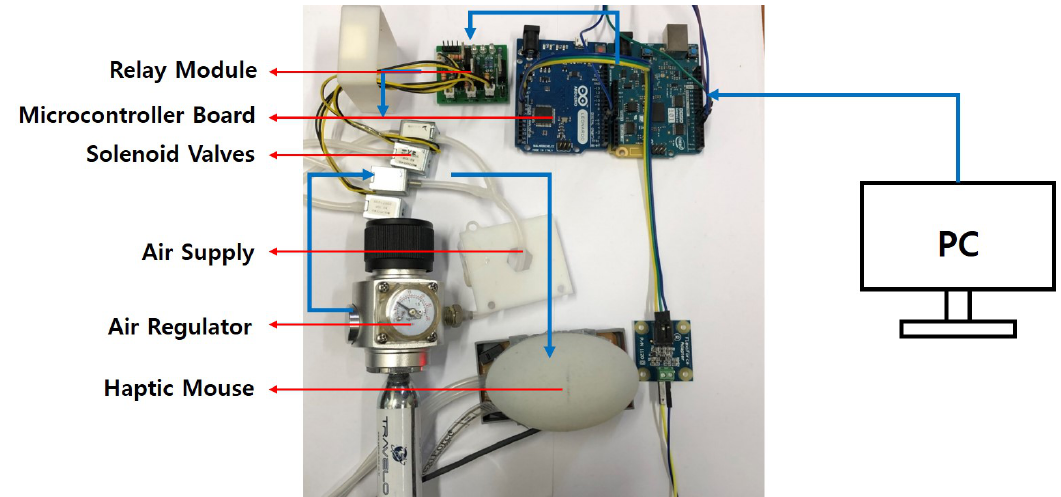
Figure 3. Pneumatic controlled hardware system showing all the components used in the control